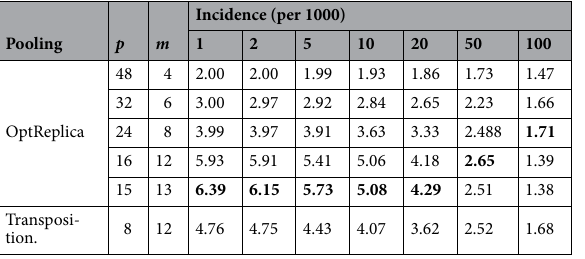
Table 1. Efficiency of OptReplica and the transposition based replication testing 96 samples. The best results for each incidence are marked in